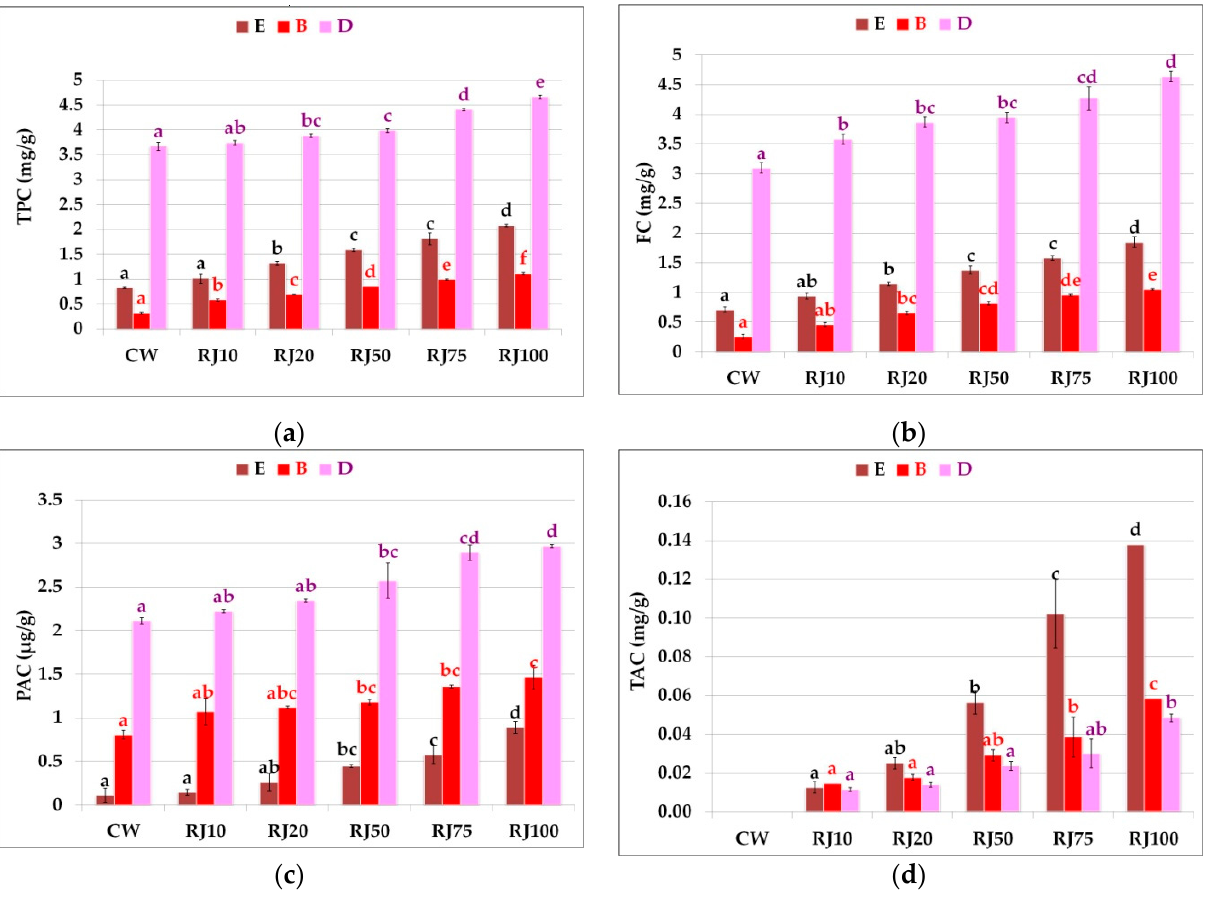
Figure 3. Phenolic compound content in the different extracts from the control and fortified wafers. ( a ) Total phenolic content; ( b ) flavonoid content; ( c ) phenolic acid content; ( d ) anthocyanin content. E—ethanolic extract; B—buffer extract; D—extract after in vitro digestion. CW—control wafers, RJ10–RJ100—wafers with raspberry juice addition (from 10% to 100% water substitution, respectively). All values are mean ± standard deviation for triplicate experiments. Different letters indicates statistically significant differences between the samples within the same type of extract ( p < 0.05).